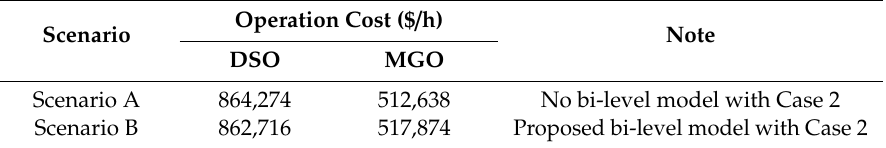
Table 4. Comparison of operational costs for scenarios in Case 2.